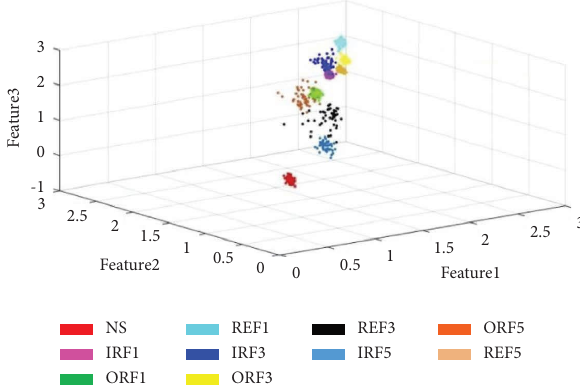
Figure 11: 3-D feature cluster diagram of diferent fault degrees.